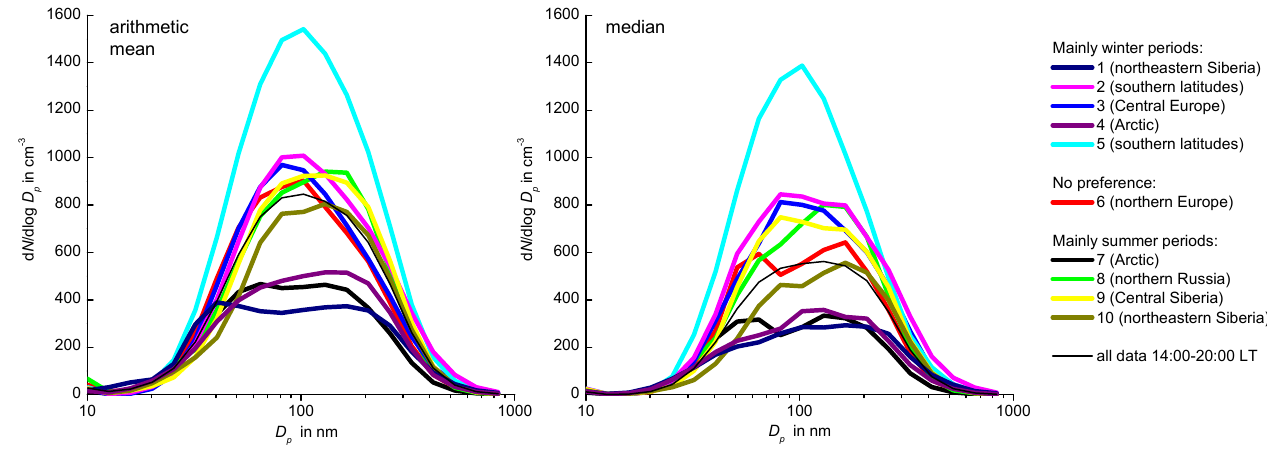
Fig. 10. Mean and median particle number size distributions for the ten trajectory clusters depicted in Fig. 8. Only data between 14:00 and 20:00LT entered into the calculations, which correspond to the 19:00LT radio sounding at